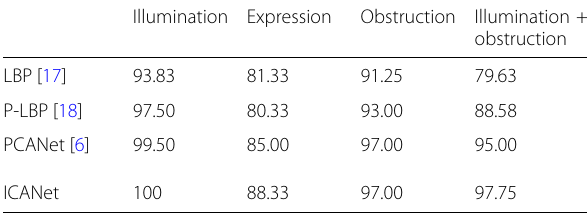
Table 2 ICANet performance comparison with other algorithms using AR ICANet recognition performance on AR data Illumination Expression